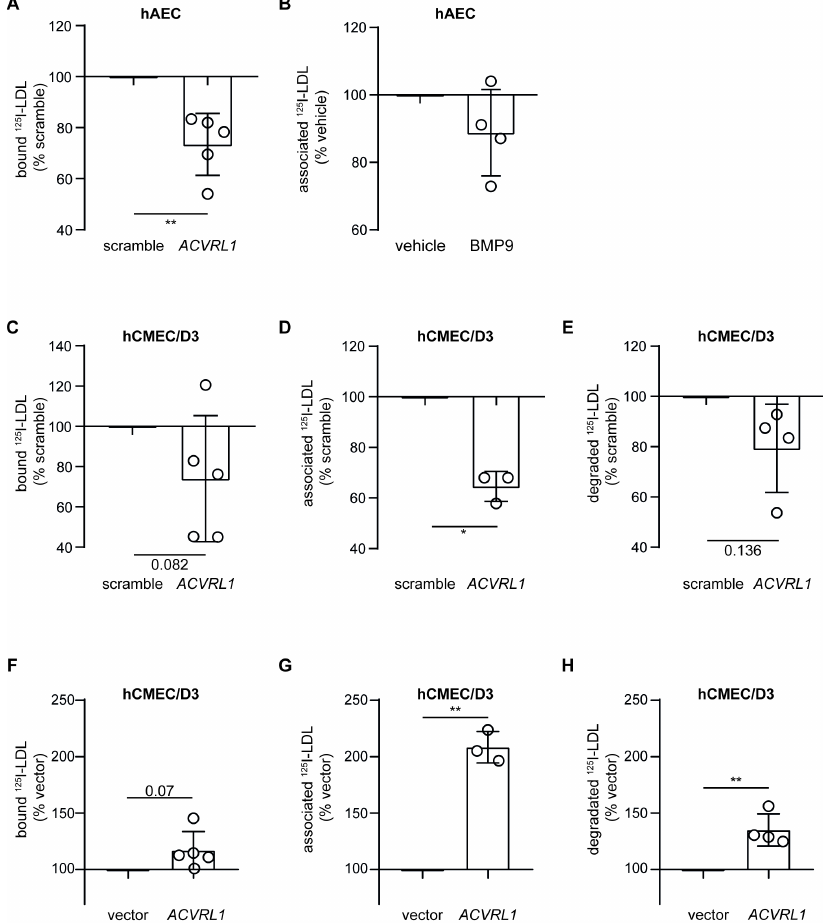
Figure 5. Knockdown and overexpression of ACVRL1 reduces and increases LDL degradation by hCMEC/D3, respectively. ( A ) Seventy-two hours after silencing ACVRL1 using siRNA, I 125 -LDL